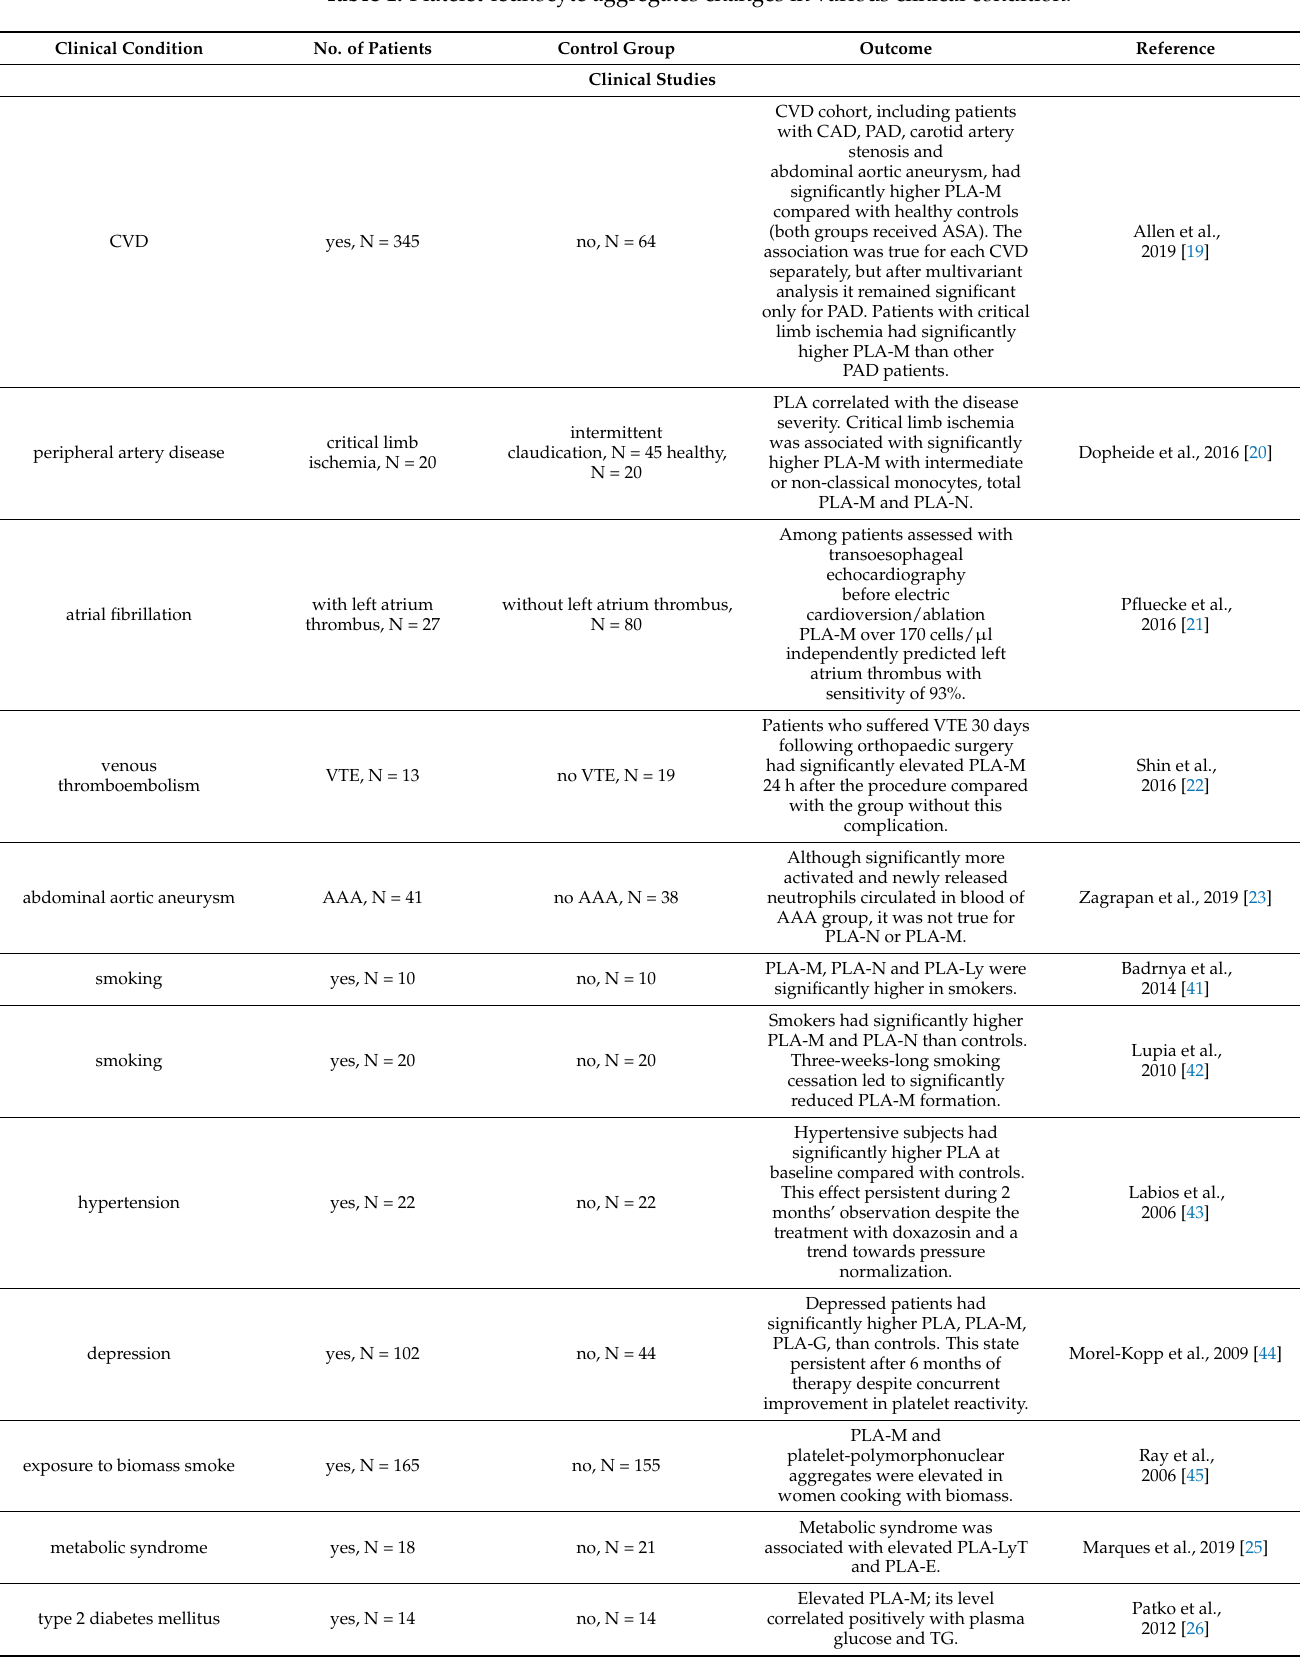
Table 1. Platelet-leukocyte aggregates changes in various clinical